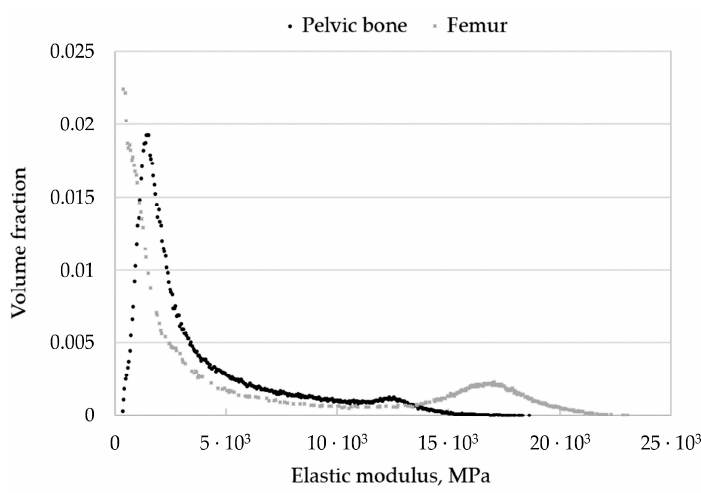
Figure 17. Distribution of elastic moduli over the bone.